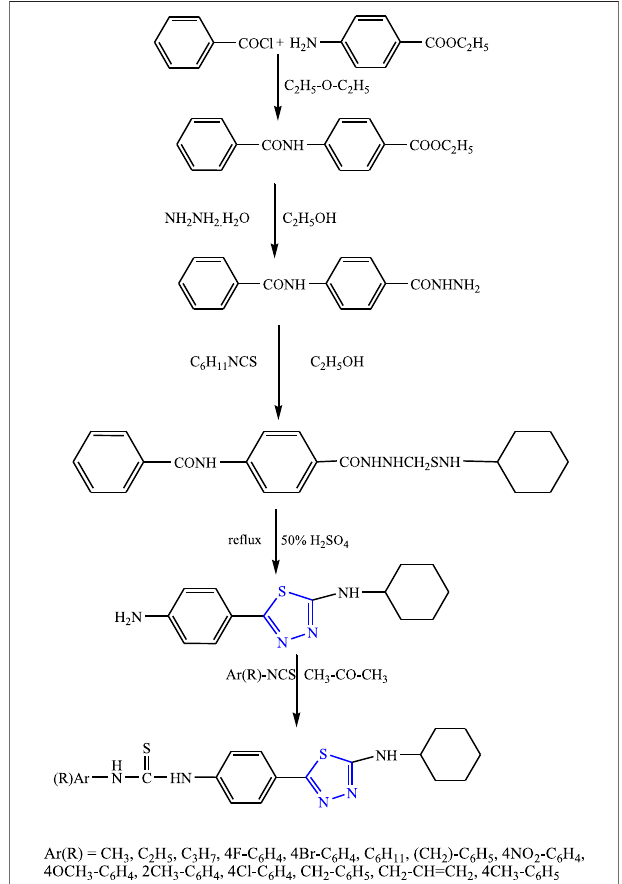
FIGURE 26 | Synthetic pathway for designing 1,3,4 thiadiazole derivatives.